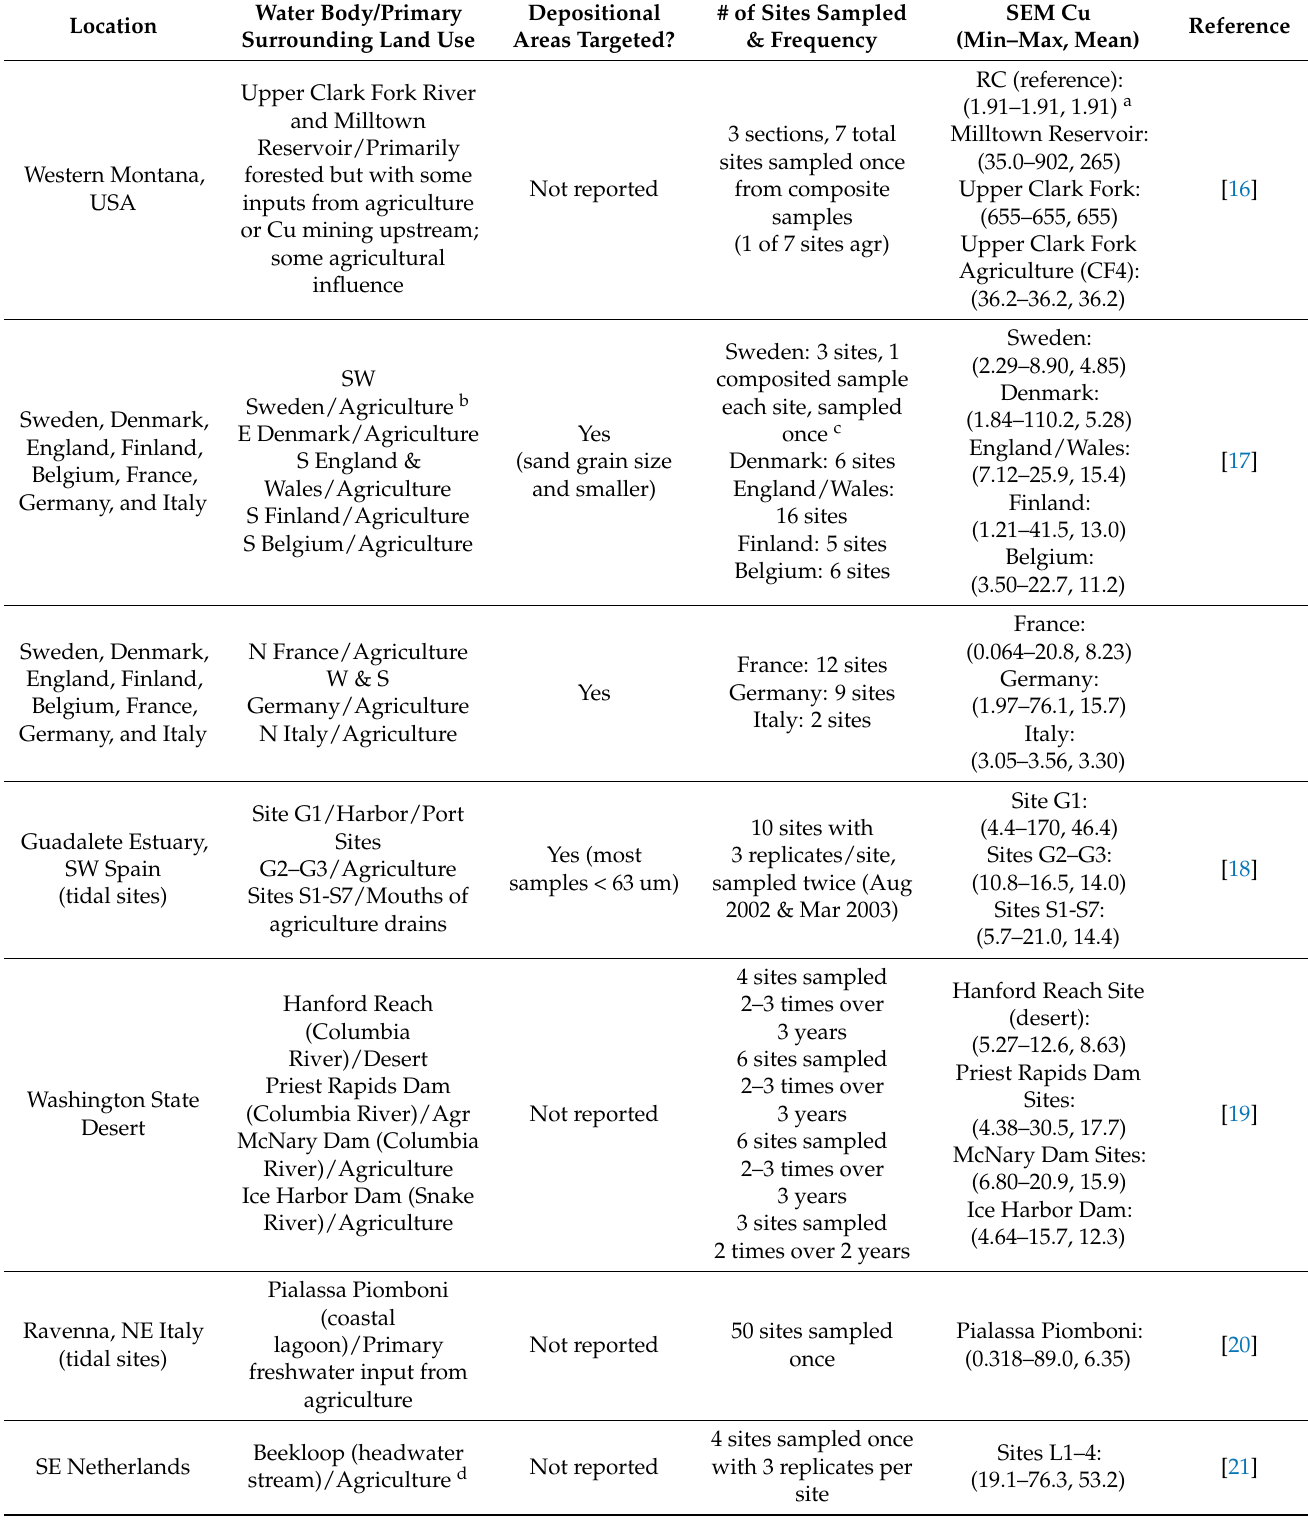
Table 4. Summary of historical sediment SEM copper data ( µ g/g dry wt) with agricultural